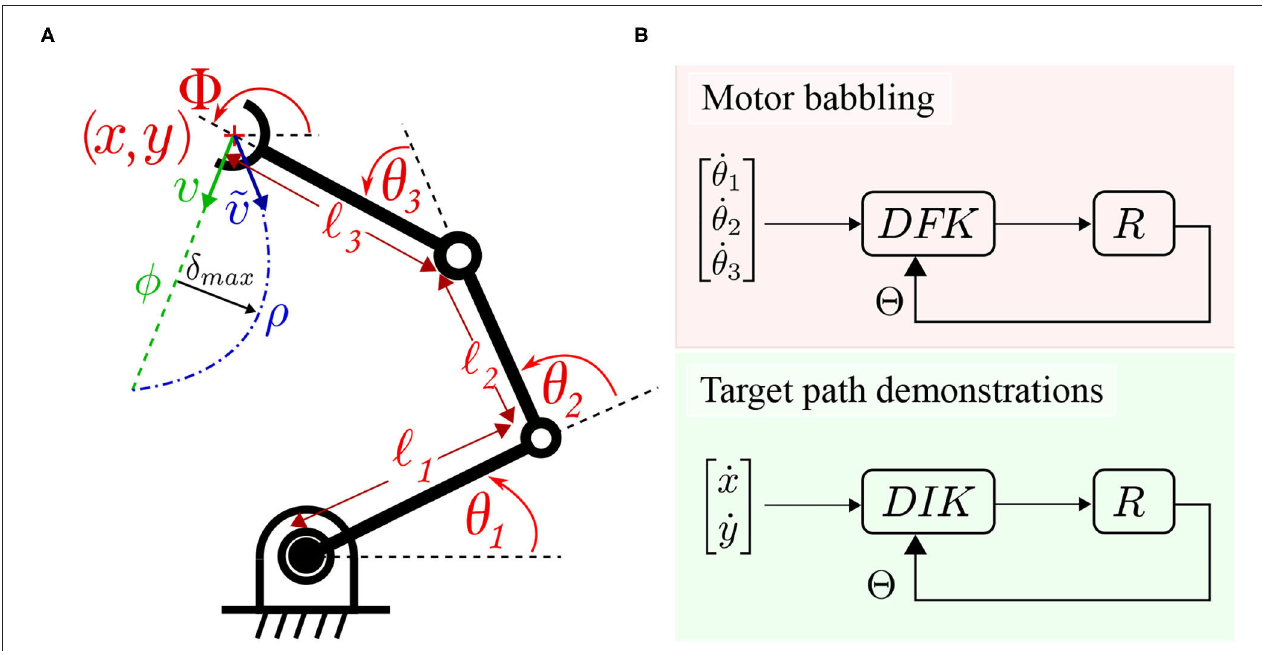
FIGURE 4 | (A) A three link planar arm employed for numerical simulation. The robot deviates from a target path φ while moving from the current pose to the target pose to move through ρ instead. (B) The data collection schemes are illustrated. Motor babbling (in the upper panel) commands linear motion in joint space under the guidance of a differential forward kinematic DFK solver. Target path follower (in the lower panel) under the guidance of a differential inverse kinematic DIK